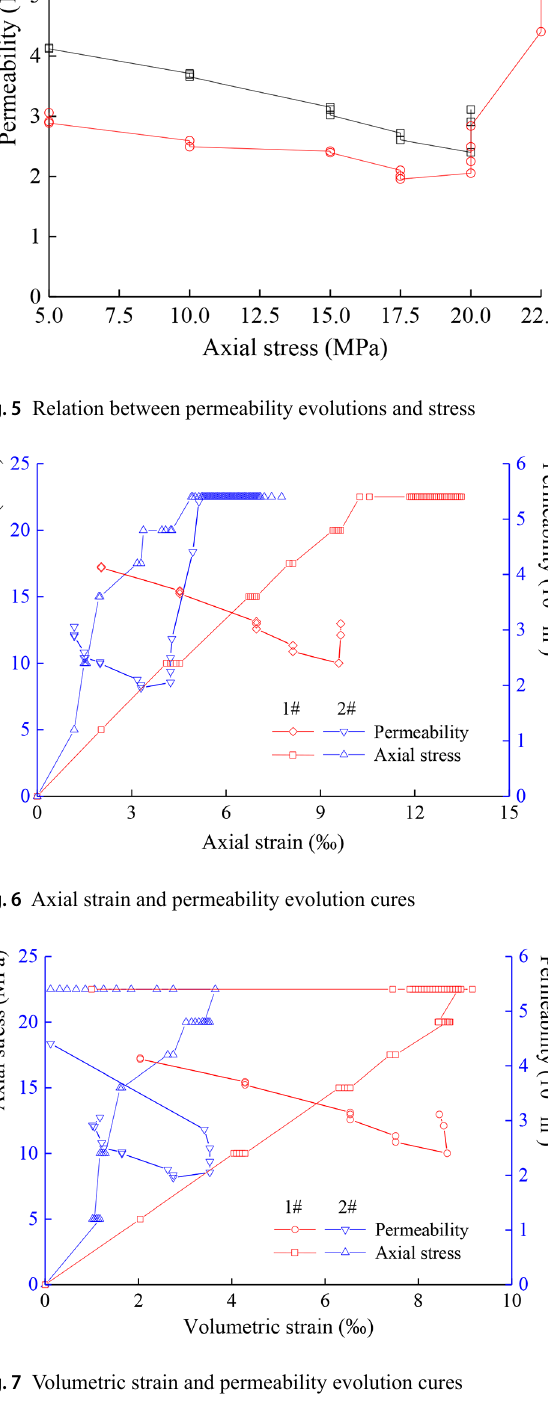
Fig. 7 Volumetric strain and permeability evolution cures